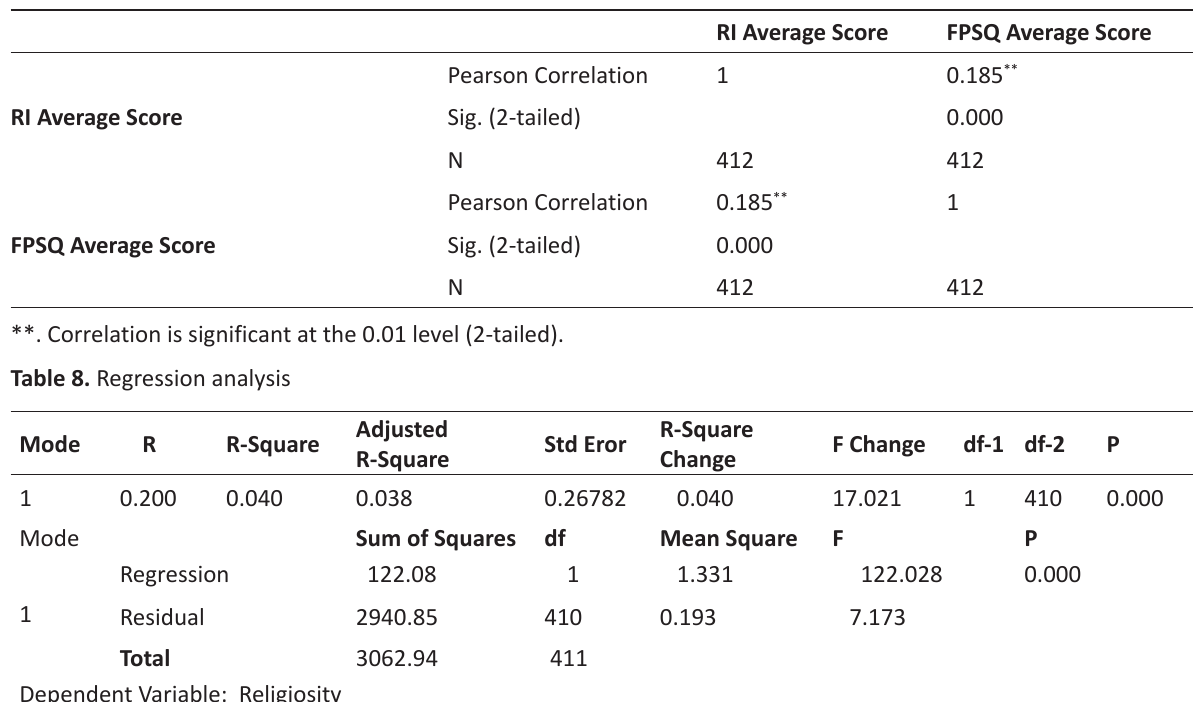
Table 7. Correlation between two scales